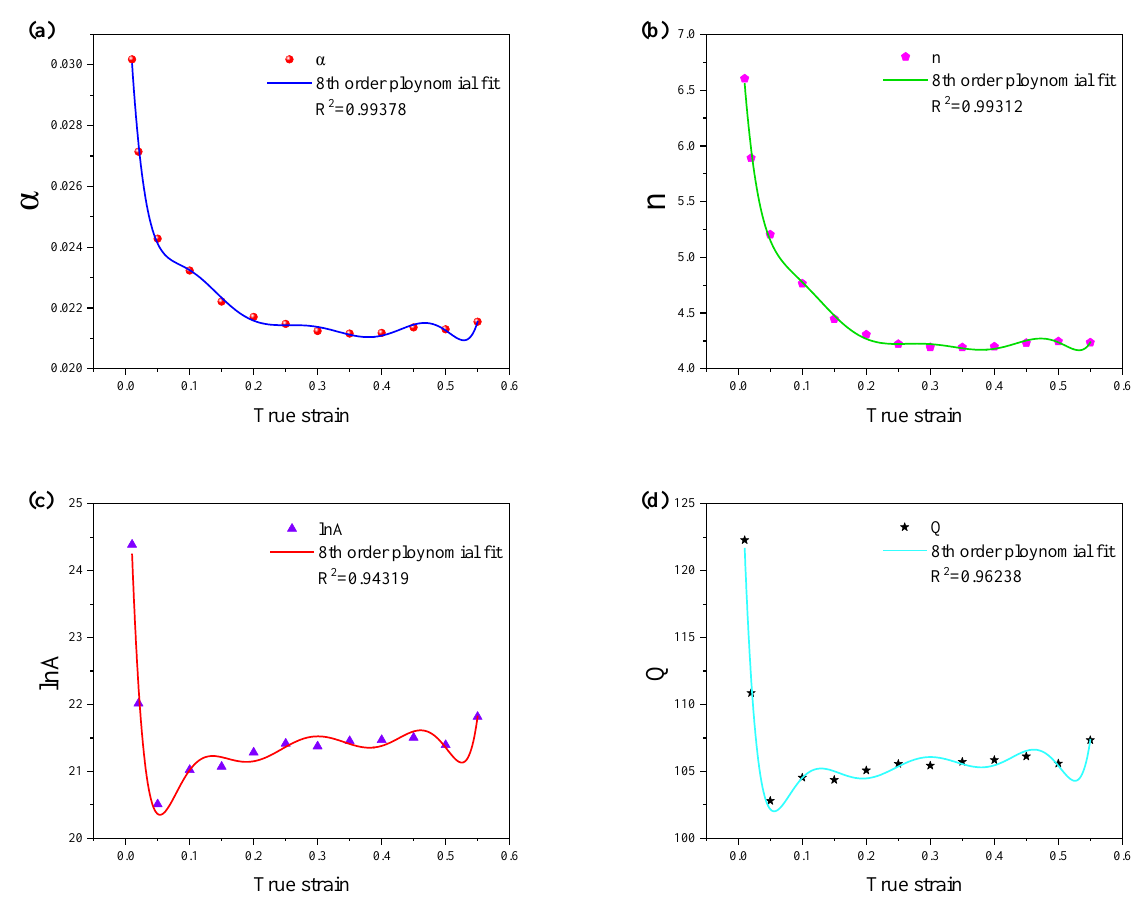
; ( b ) 1000/T~ln[sinh( ασ )]. 𝜀𝜀̇